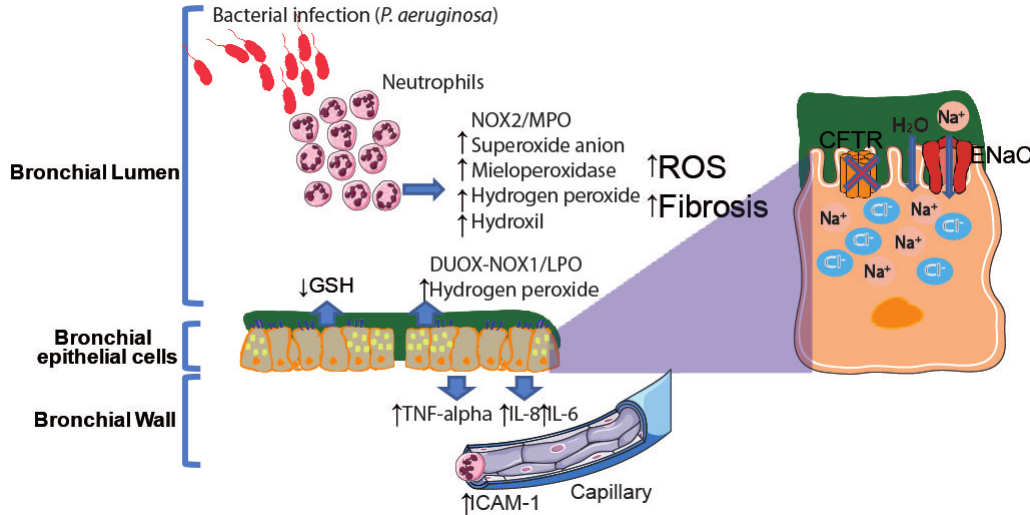
Figure 1. Redox imbalance in the conductive airways of patients a ff ected by cystic fibrosis (CF). Cystic fibrosis transmembrane conductance regulator (CFTR) dysfunction in lungs prevents Cl − secretion and induces Na + hyperabsorption at the airway apical surface, dehydration and impairment of mucociliary clearance. These events favor bacterial infection and prevent its elimination, inducing epithelial cells to secrete proinflammatory cytokines such as IL-8 and IL-6 and TNF-alpha, which attract neutrophils at the site of infection. As a result, a vicious cycle of neutrophilic inflammation and oxidative stress, produced by the release of large amounts of reactive oxygen species (ROS) both from epithelial cells and neutrophils through DUOX and NOX2, respectively, leads to irreversible airway destruction and fibrosis. Furthermore, low glutathione (GSH) levels further increase the oxidative stress. ROS also increase the migration of neutrophils from capillary